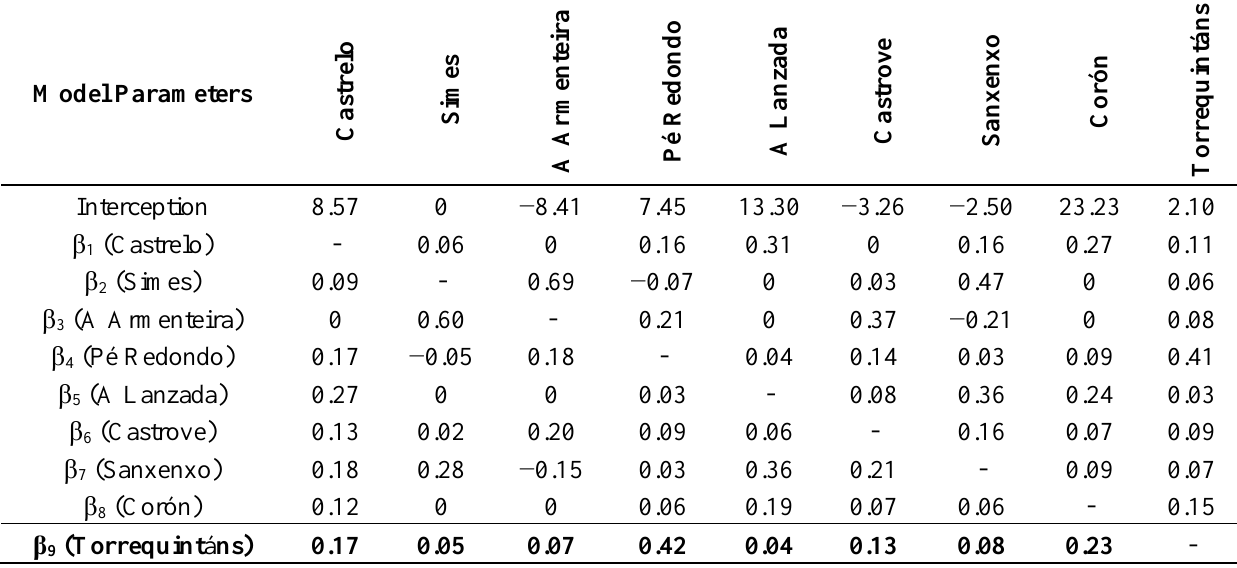
Table 6. Multiple Linear Regression Models for each location.